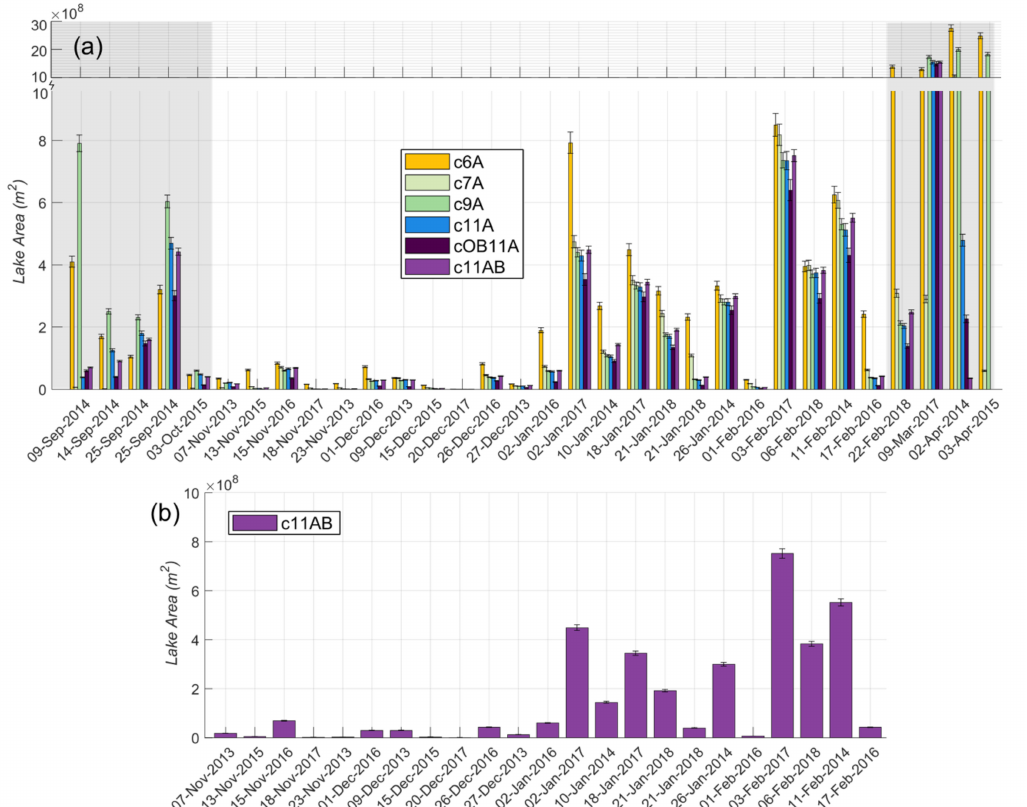
Figure 3. Lake areas are identified across a set of application scenes across the Amery Ice Shelf, categorized by date of image acquisition. Classifiers were generated from di ff erent training datasets. Manual cloud / cloud shadow polygons and the rock mask were applied prior to classification. ( a ) Grey shading indicates scenes with sun elevation below 20 ◦ . Note the upper scale is compressed to show the exceedingly high (misclassified) lake areas for some low-sun-elevation scenes. Error bars reflect the validation accuracy of each classifier (Table 3). ( b ) c11AB classifier results with low-sun-elevation scenes removed. For the final scene (April 3, 2015) the c11A, cOB11A, and c11AB classifiers produced zero lake